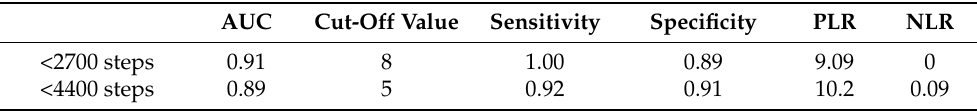
Figure 1. ROC analysis of gait pattern examination. Table 3. Test characteristics of the gait pattern.